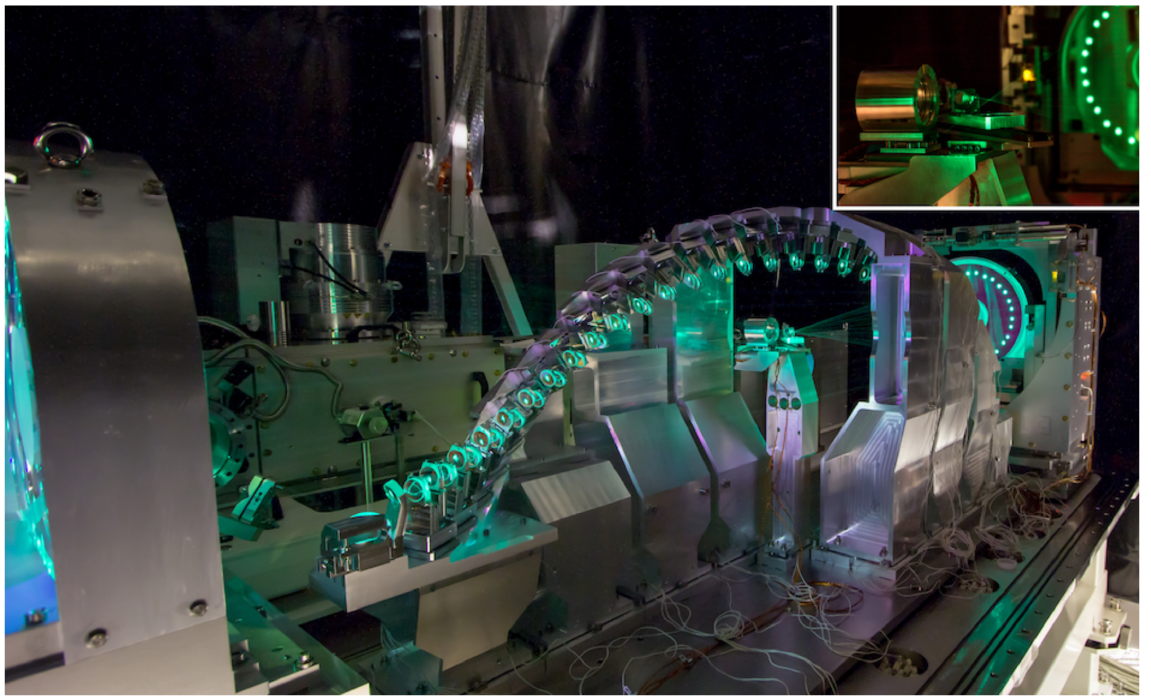
FIG. 21. Pictures of the LBC in air with all the MPS installed before the fine tuning of the alignment. M1 is placed on the left and M2 on the right hand side of the picture. At the center the TFP is retracted and the first UHVobjective can be seen. A magnification of this IP region is given in the inset. Courtesy of N. Beaugerad,